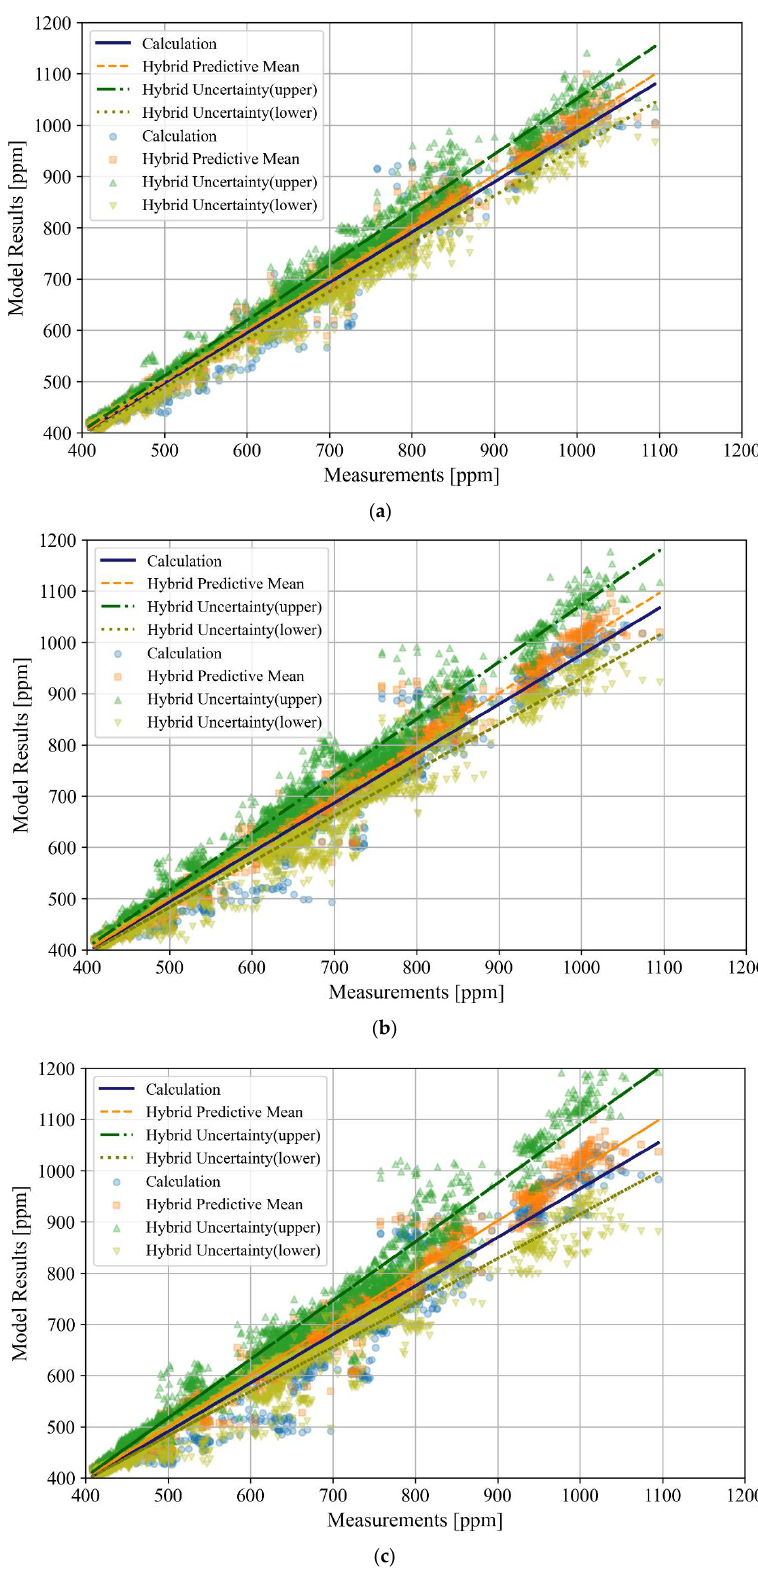
Figure 5. Scatter plot of the forecasting results obtained using the hybrid model and mass balance equation for the BR1 zone for the prediction horizons of ( a ) 5 min, ( b ) 10 min, and ( c ) 15 min.